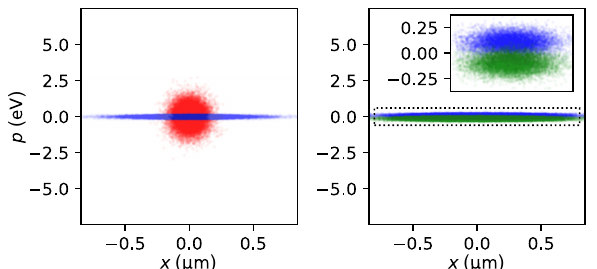
FIG. 6. A qualitative example of the requirements for nanopar- ticle state preparation and measurement following the decay. (a) A comparison between the quasiprobability distribution for the zero-point motion of the COM of a 5-nm-diameter graphene flake cooled to the ground state of a weakly confining har- monic potential ( ω = 2 π × 100 Hz) (red) and after squeezing the momentum quadrature of the motional state of the nanoparticle by 20 dB (blue). (b) The quasiprobability distribution following the decay for the nanoparticle COM (blue) and neutrino (green), assuming that all secondary particles are trapped within the flake and that the ν carries momentum | p ν | = 100 meV. The inset shows an enlargement of the region highlighted by the black dotted box in the main